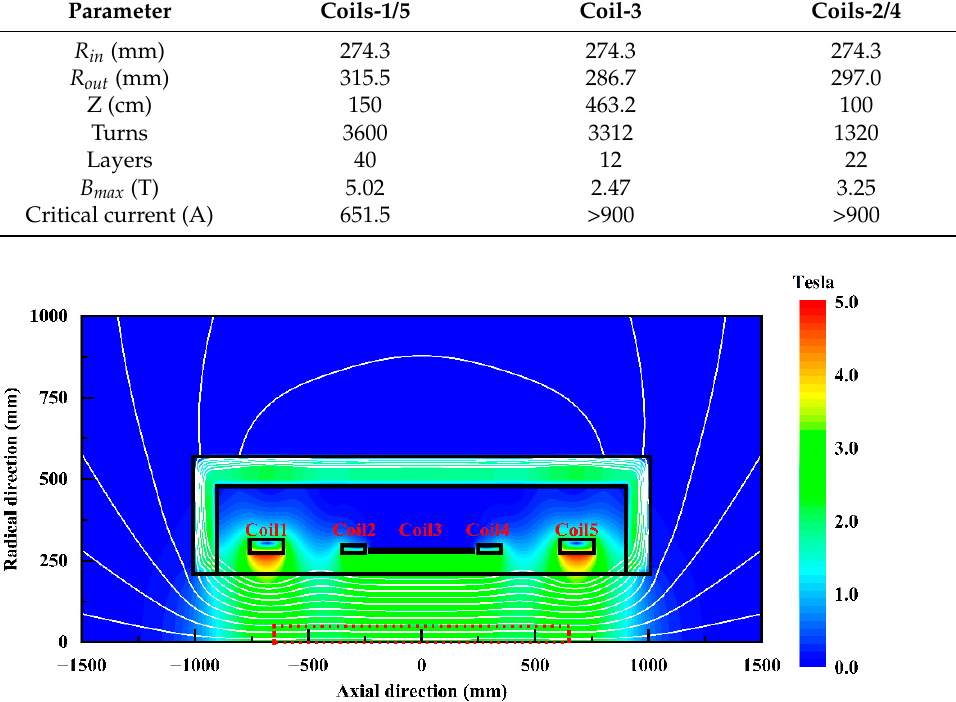
Figure 6. The calculated 2D magnetic field distribution. The main transmission region of the plasma beam is surrounded by red dots, with an axial length of 1300 mm and a radial radius of 50 mm. Magnetic field lines are almost flat in this region .